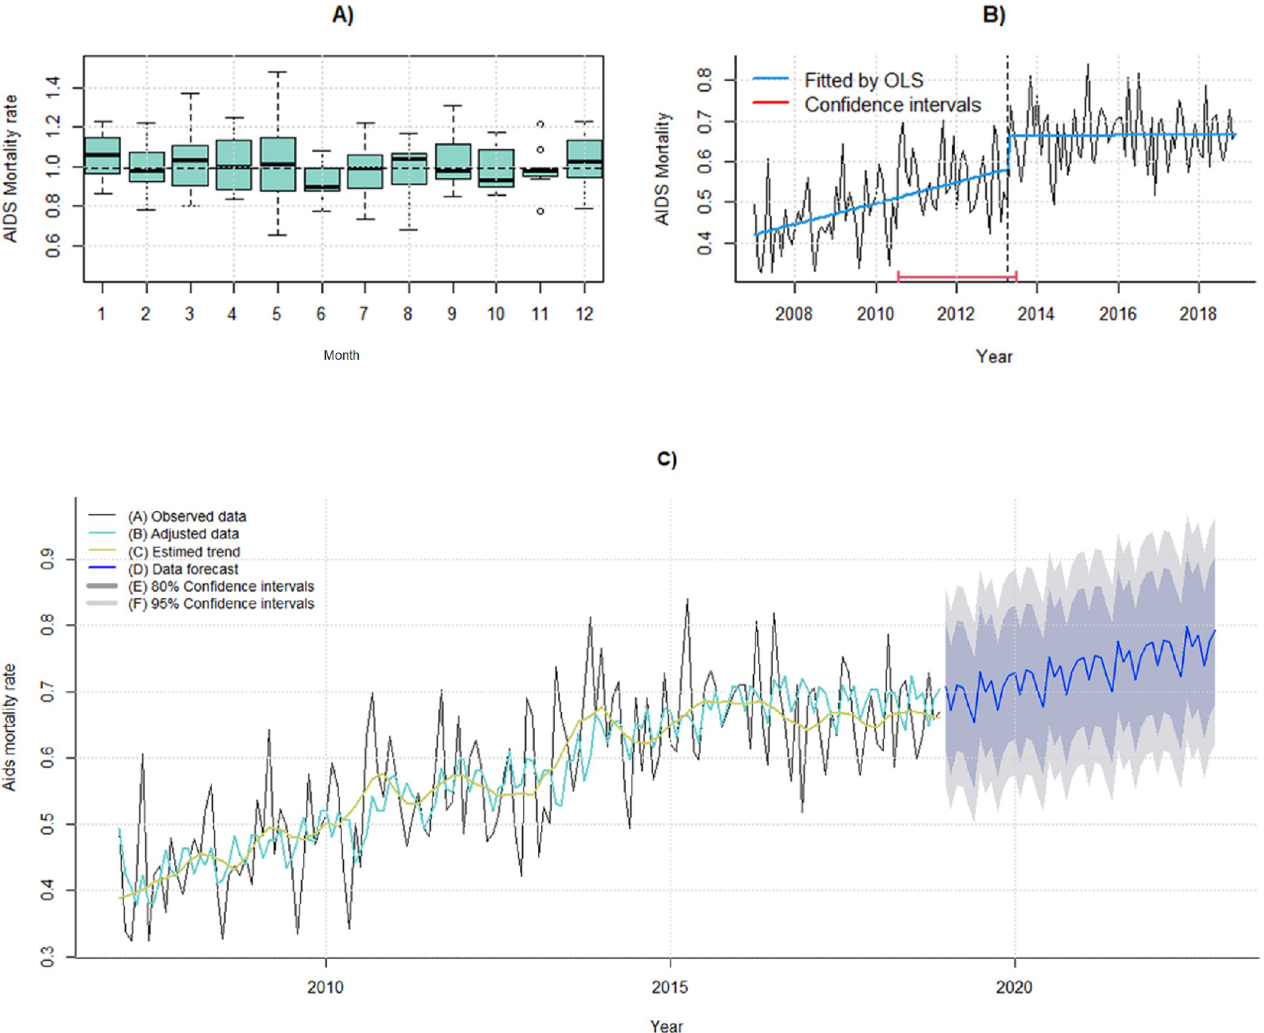
Fig 2. Analysis of the historical series of AIDS mortality rate in the state of Para´ from 2007 to 2018. A) Monthly variability of AIDS-mortality rate (standardized by age), B) Variability of the temporal trend of AIDS- mortality rate, and C) Forecast of AIDS-mortality rate in Para´ from 2019 to 2022 according to the ARIMA model (0,1,1). Source: Authors.